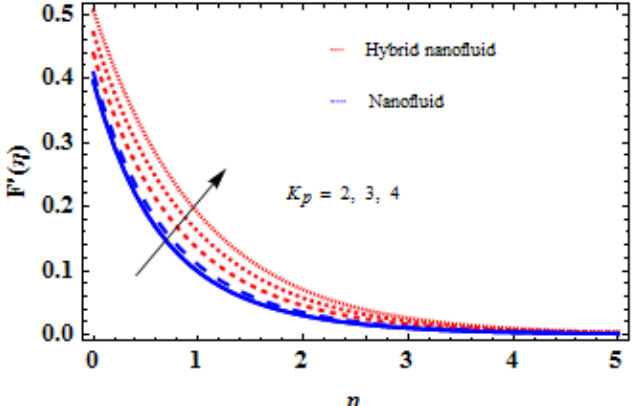
Figure 9. Influence of 𝐾 𝑝 via dust speed.